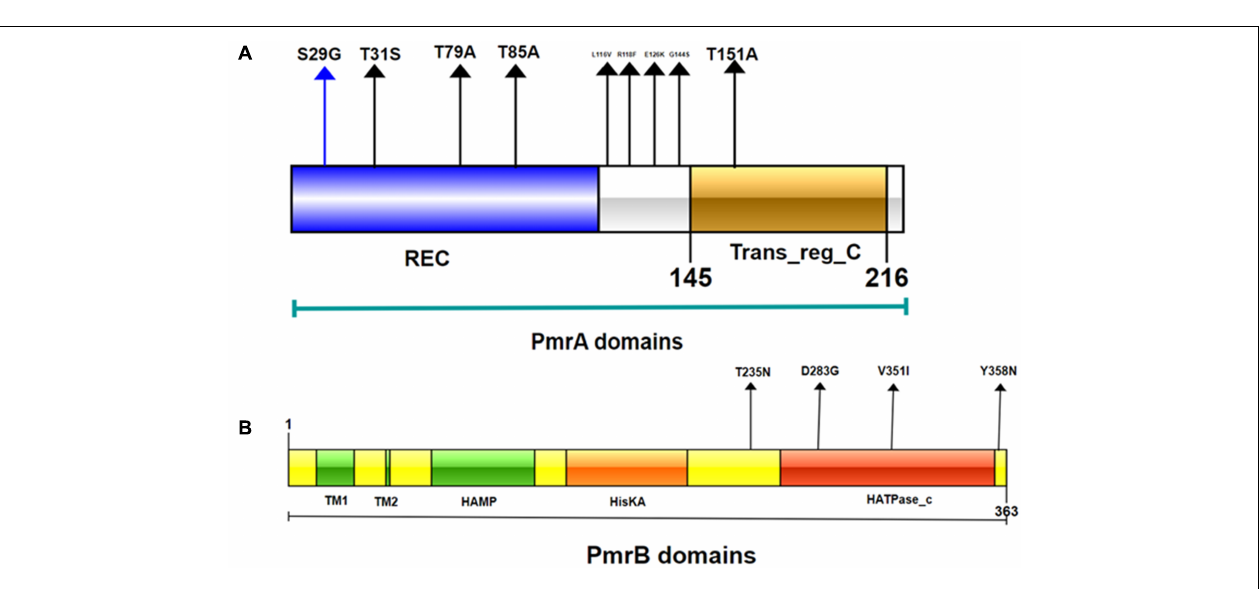
FIGURE 6 | Domains of the PmrA/PmrB two-component system and positions of all mutations conferring colistin resistance to E. coli. (A) PmrA domains, cheY-homologous receiver domain [REC]; aa 1-112. Transcriptional regulatory protein, C-terminal domain [Trans_reg_C]; aa 145–216. S29G, T31S, T79A, T85A, L116V, R118F, E126K, I128N, G144S, and T151A represent mutation site. (B) PmrB domains, first transmembrane domain [TM1]; aa 15–34; second transmembrane domain [TM2]; aa 66–68. histidine kinases, adenylyl cyclases, methyl binding proteins, phosphatases [HAMP domain]; aa 89-141. Histidine kinase A (phosphoacceptor) domain [HisKA]; aa 142–202. Histidine kinase-like ATPases [HATPase_c]; aa 249-357. D283G, V351I, and Y358N represent smutation